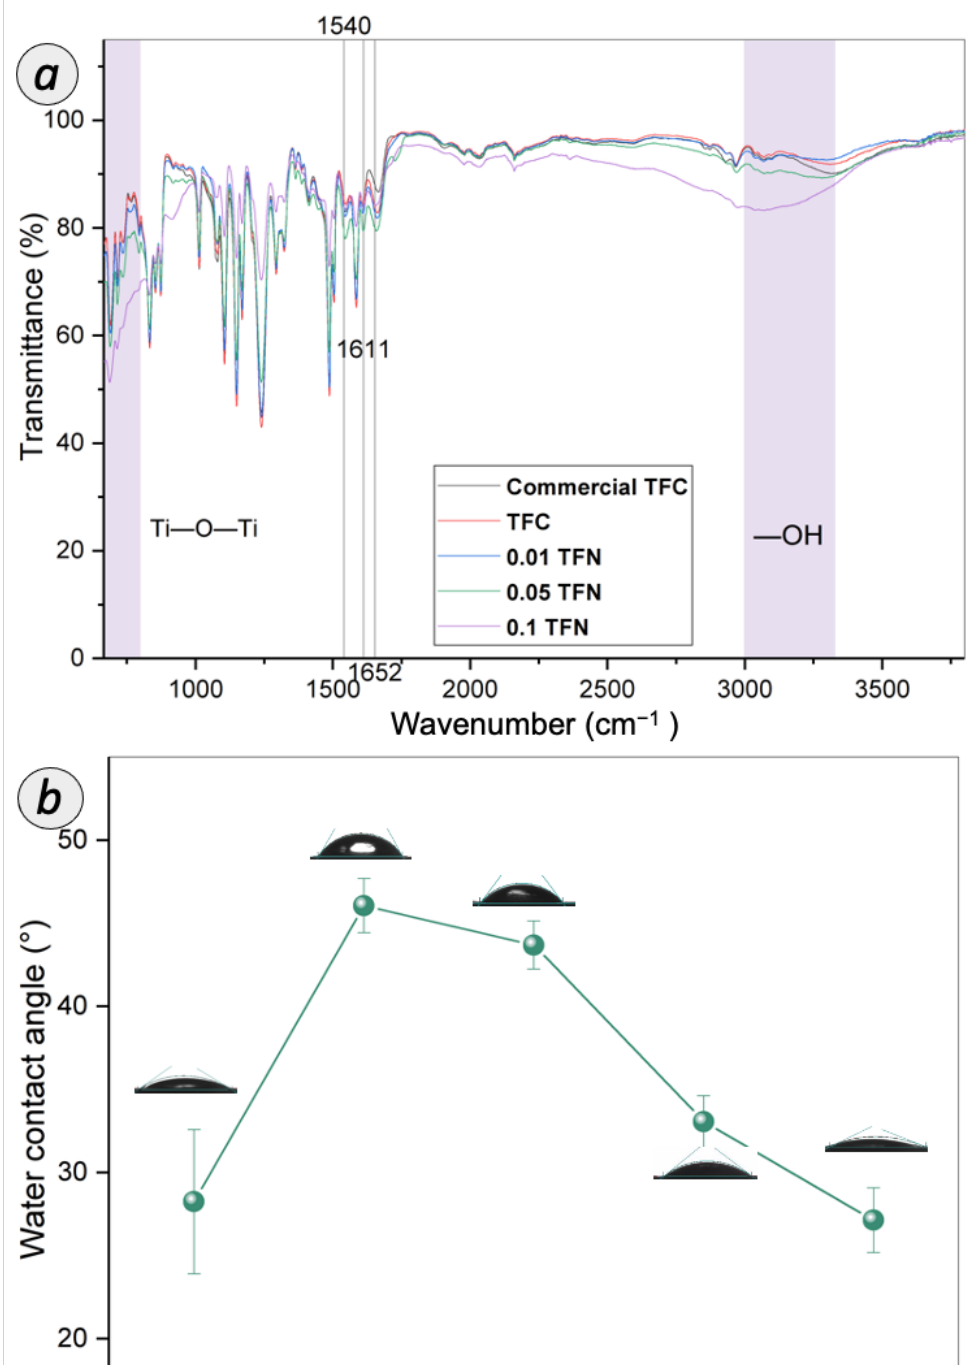
Figure 8. ( a ) ATR-FTIR spectra and ( b ) water contact angle of TFC and TFN membranes. Water contact angle is an important parameter of RO membrane, as it reflects the surface hydrophilicity, which can be related to the flux and productivity of the membranes. Figure 8b displays the water contact angle of TFC and TFN membranes. The surface contact angle of pristine TFC membrane was 46.1 ± 1.63°, which falls within the range of the typical PA layer [38]. The water contact angle of commercial TFC membrane is 28.3°,